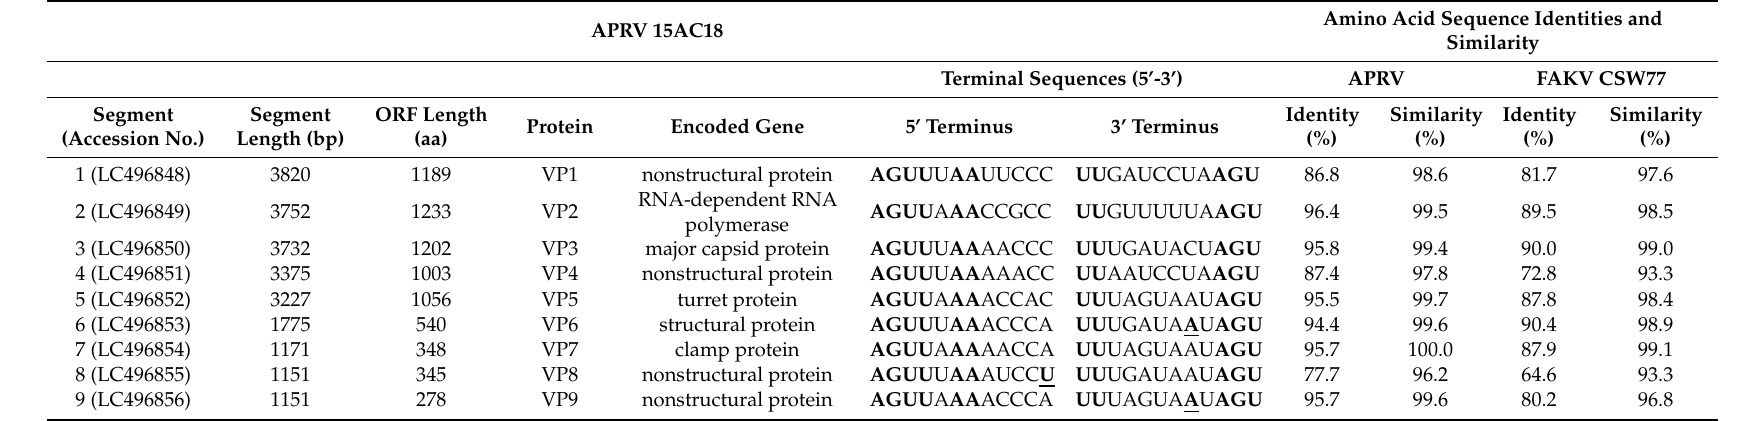
Underlined sequences are points of nucleotide